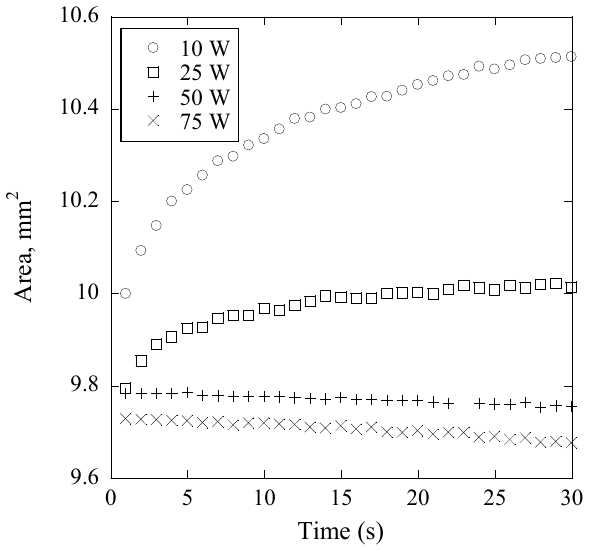
Figure 4. Solid/liquid contact area (mm 2 ) evolution over time (30 s) for pp–GT thin films.